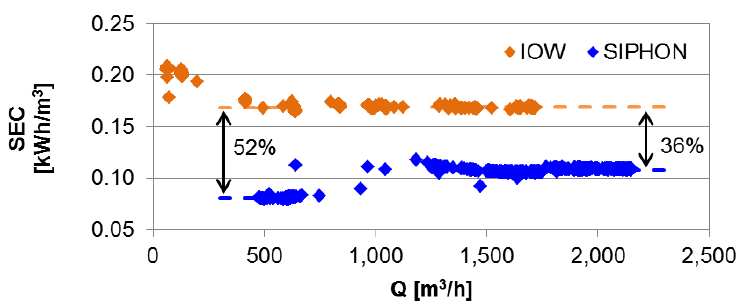
Figure 7. Measured SEC as function of discharge for siphon wells and IOW at Dresden-Hosterwitz.